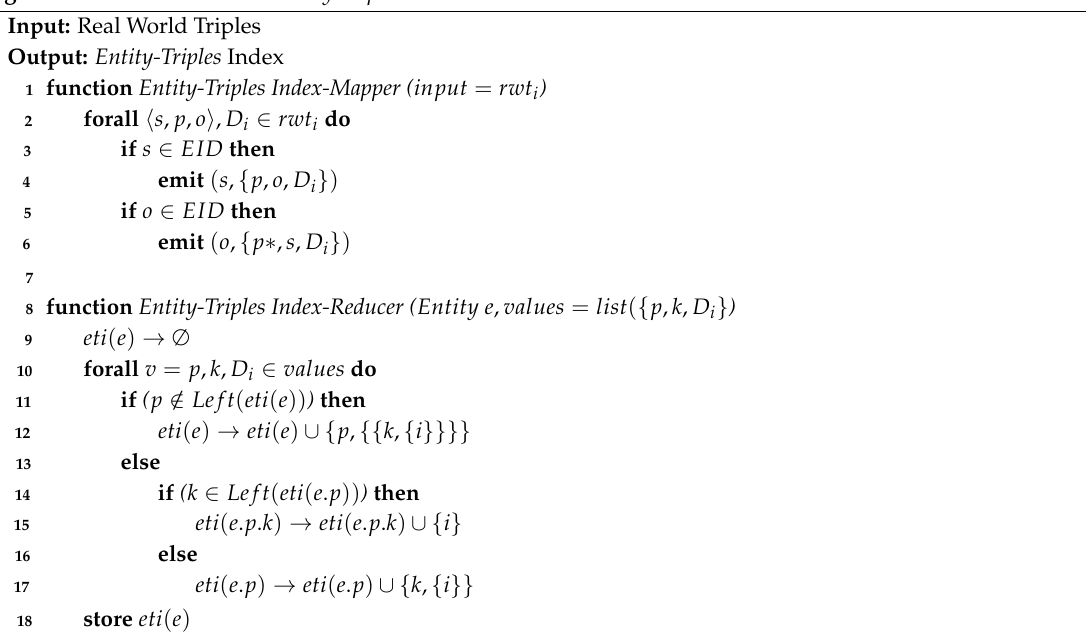
Algorithm 2: Construction of Entity-Triples